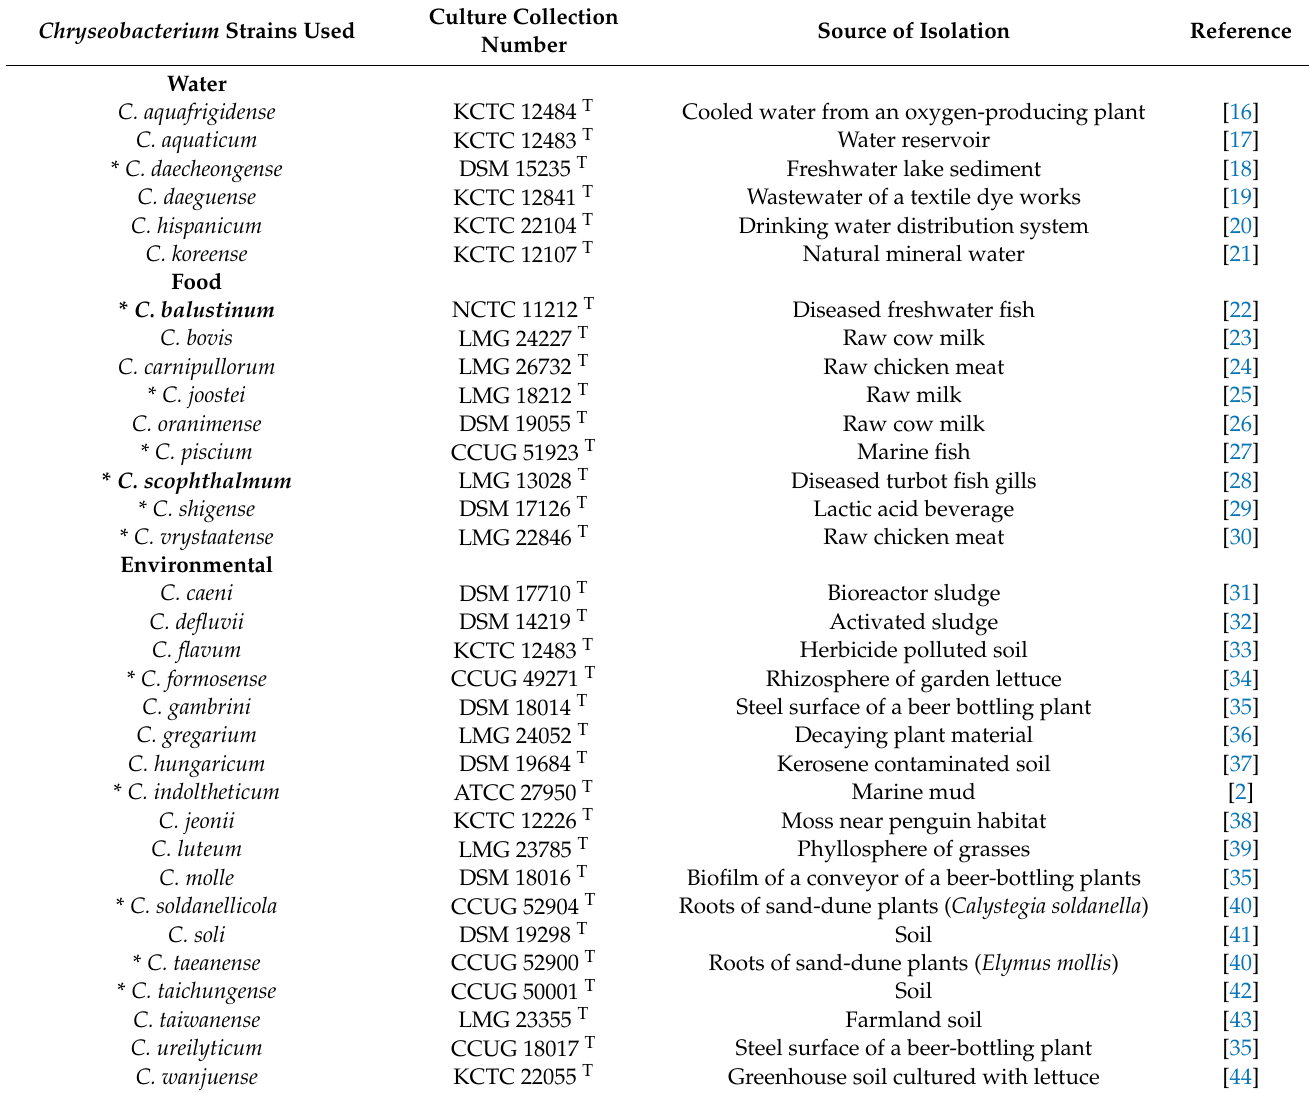
Table 1. Type strains used in the determination of pathogenic characteristics of Chryseobacterium species from food and environmental sources. Strains indicated in bold are the reference pathogenic strains used in this study. * Strains selected for the disinfectant resistance